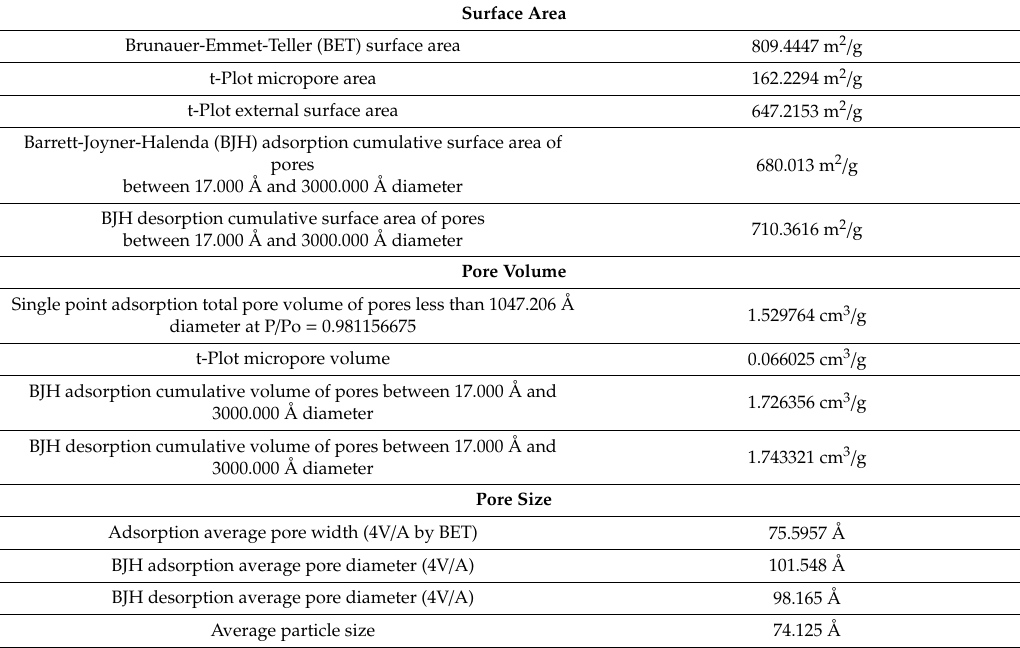
Table 2. Summary of nitrogen adsorption-desorption data for synthesized